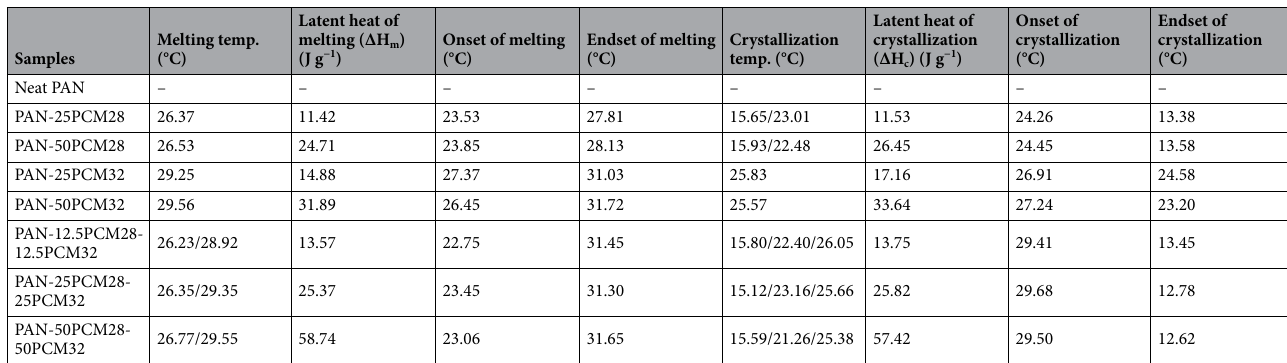
Table 4. Thermal properties of composite PAN/PCM nanofibers between 5 and 45